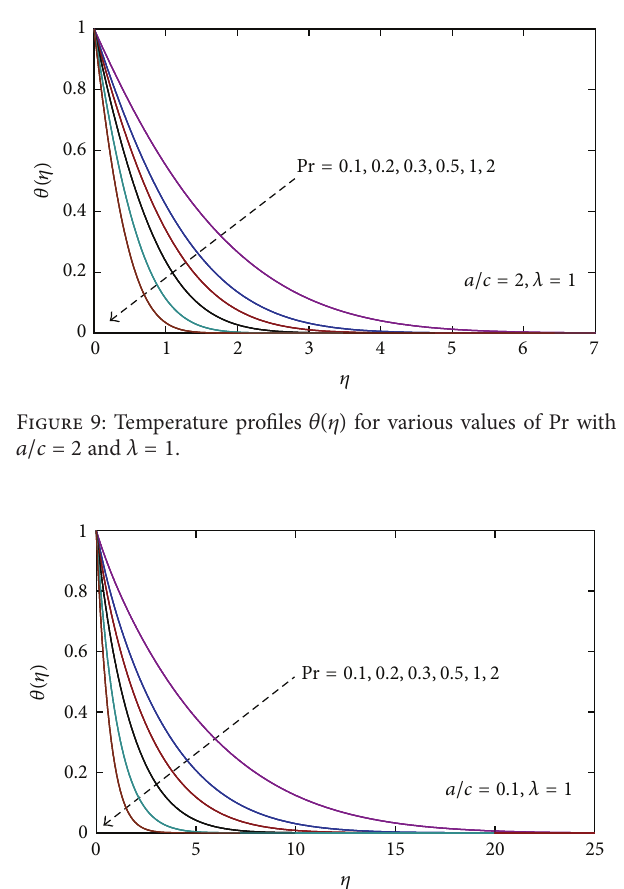
Figure 10: Temperature profiles 𝜃(𝜂) for various values of Pr with 𝑎/𝑐 = 0.1 and 𝜆 = 1 .